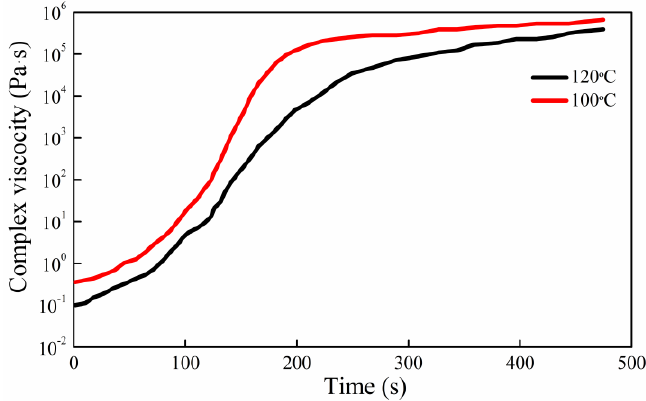
Figure 4. Viscosity curves of the mixed liquid at 100 °C and 120 °C.